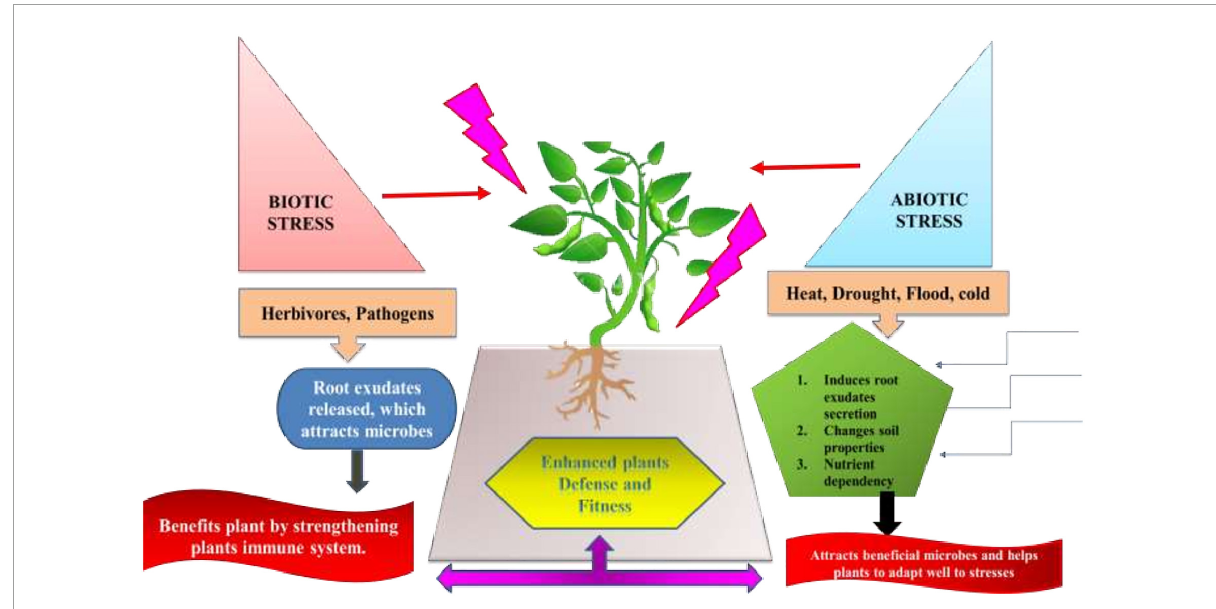
FIGURE7 ‘Defense Biome’ mechanisms favoring enrichment of particular microbes under diverse abiotic and biotic stressors by modulating root exudates composition, altering soil properties and nutrients availability.